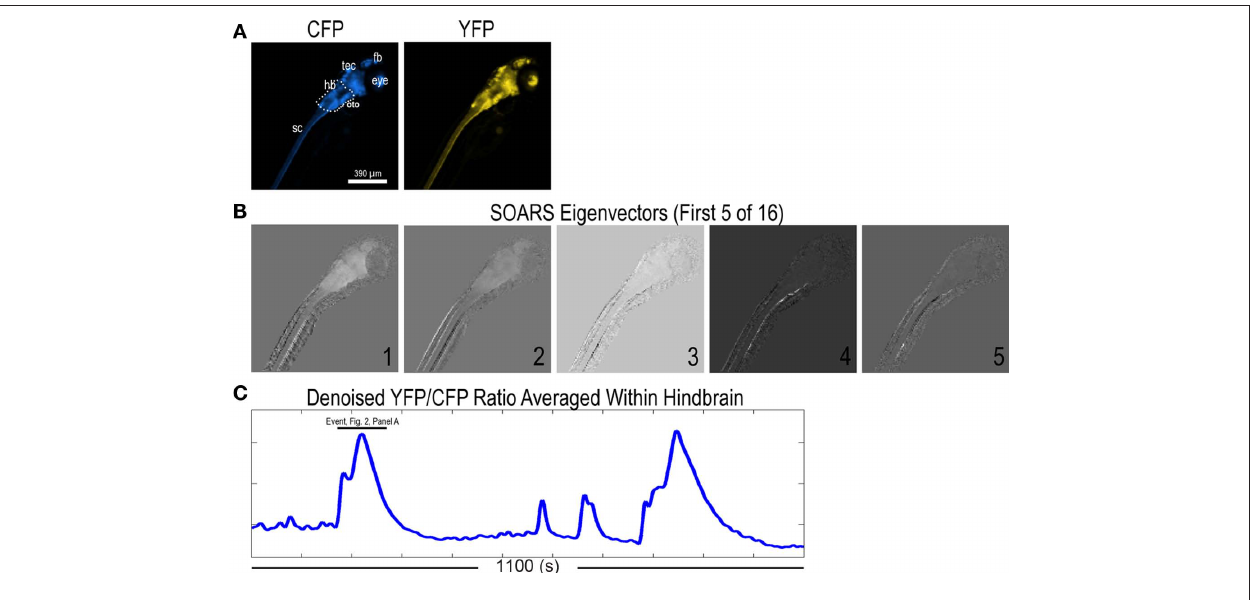
tectum, fb: forebrain). (B) Intermediate results from a SOARS analysis (Broder et al., 2007). These eigenvectors depict part of the covarying ratiometric signal that SOARS detected in this dataset. (C) The averaged, denoised ratio in a region of interest (ROI) drawn about the hindbrain [hb, see (A) ]. Four Ca 2 + events (two of large amplitude and two of smaller amplitude) are shown in this 1100 s